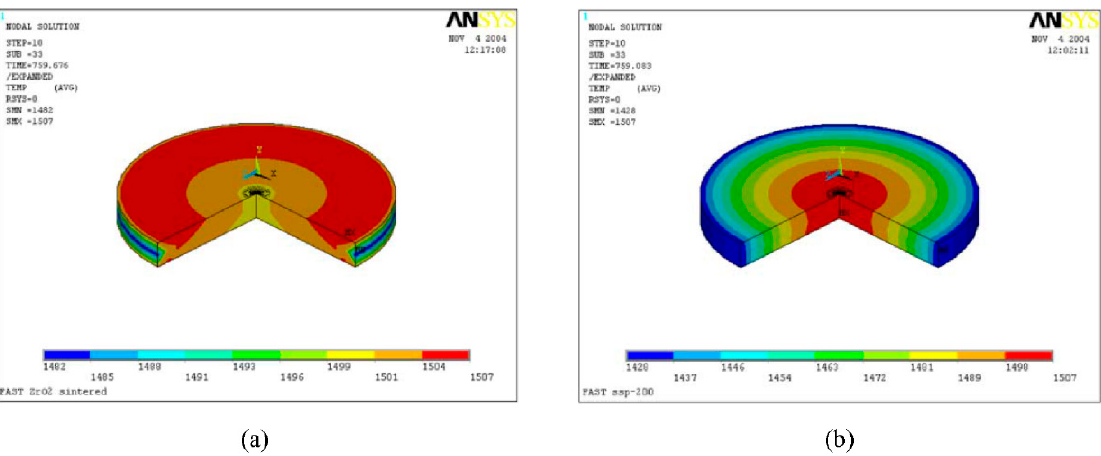
Figure 12. Temperature distribution in insulating ZrO 2 ( a ) and conducting TiN ( b ) samples during holding at 1500 °C [67]. Reproduced with permission from Acta Materialia, published by Elsevier, 2005.